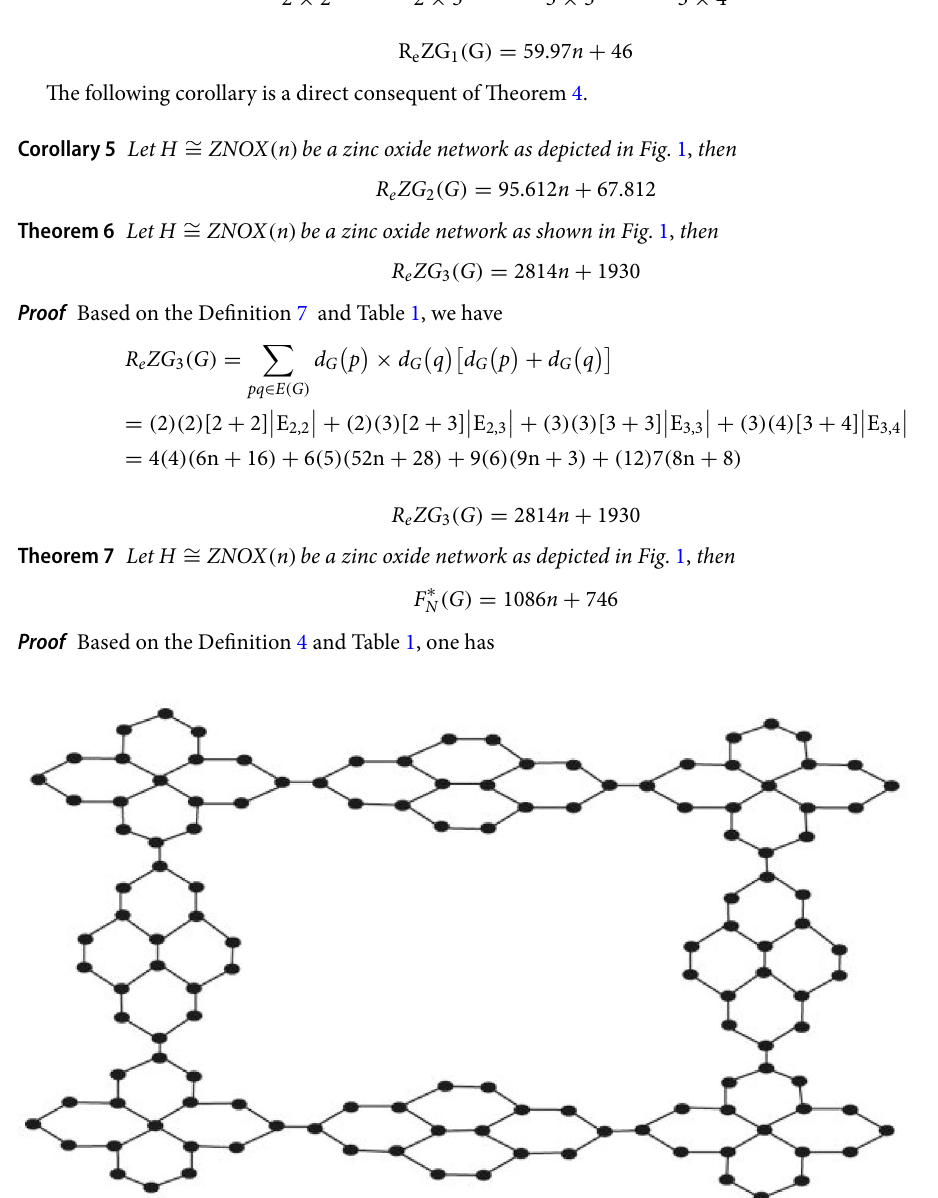
Figure 2. Zinc silicate network (ZNSL (n) ∼= K), where n